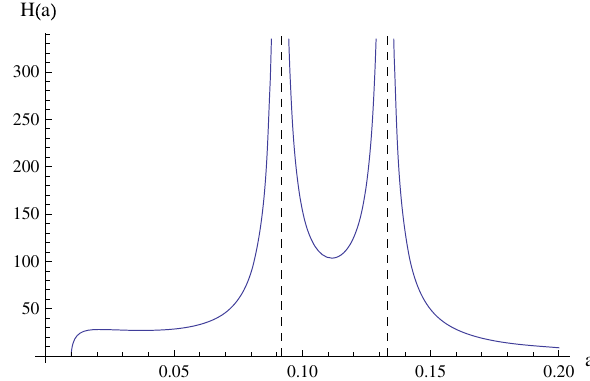
Fig. 6 The evolution of V ( a ) . This figure corresponds with Fig. 4. The black dashed lines present the freeze singularities. The potential is Fig. 4 The evolution of the Hubble function for f ( ˆ R ) = ˆ R + γ ˆ R 2 + (cid:3) (cid:4) (cid:3) (cid:4) regular at these singularities while its higher derivative blows up. The s 2 Mpc 2 s 4 Mpc 4 δ ˆ R 3 , where γ = 10 − 6 and δ = − 10 − 14 . The km 2 km 4 pole of V ( a ) represents the sudden singularity. The potential V ( a ) is black dashed lines present the freeze singularities. Note that the singu- expressed in units of 10 4 km 2 larity of the big bang type does not appear here. H ( a ) is expressed in s 2 Mpc 2 units of 100 km s Mpc